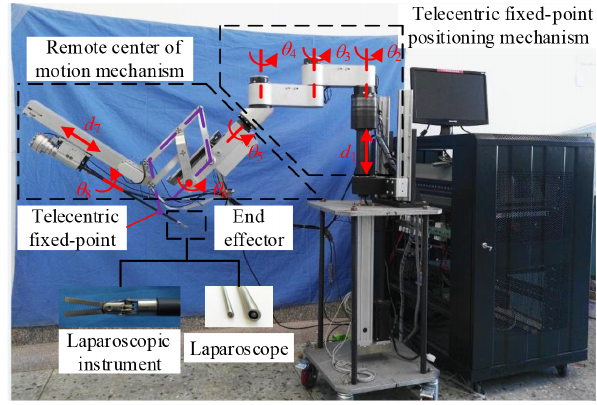
Figure 3. The structure of the robotic arm.